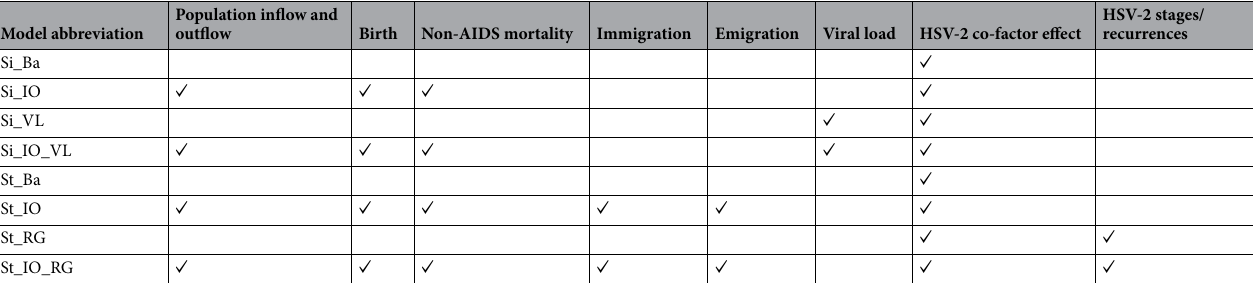
Table 2. Overview of the properties of the 8 models used in this study. Checkmarks indicate the features that are included in the